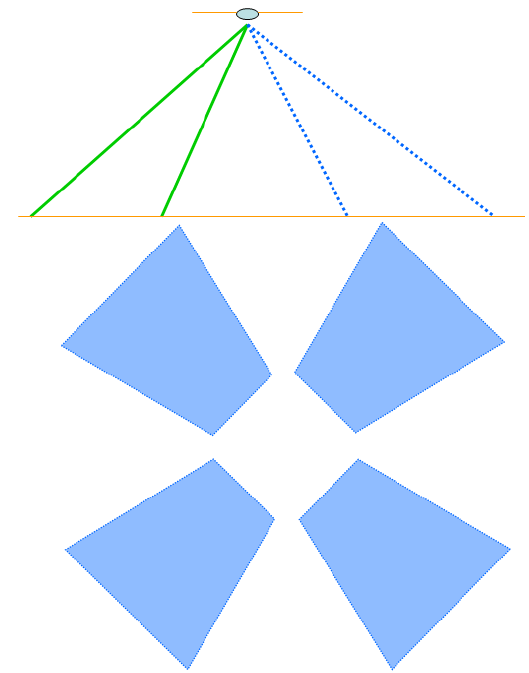
Figure 1: Four Vision System (concept) Currently a camera system with four oblique and one nadir